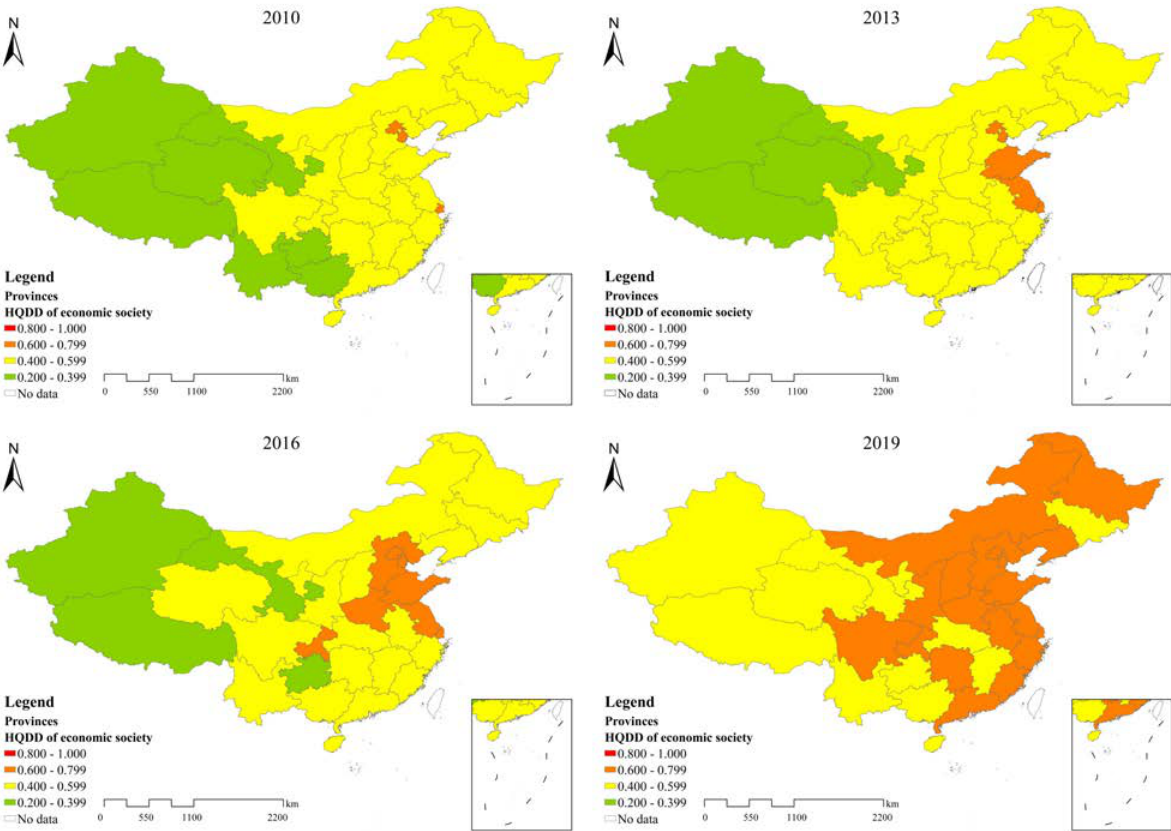
Figure 5. Spatial distribution of HQDD of the economic society system in 31 PLARs in 2010, 2013, 2016, and 2019.